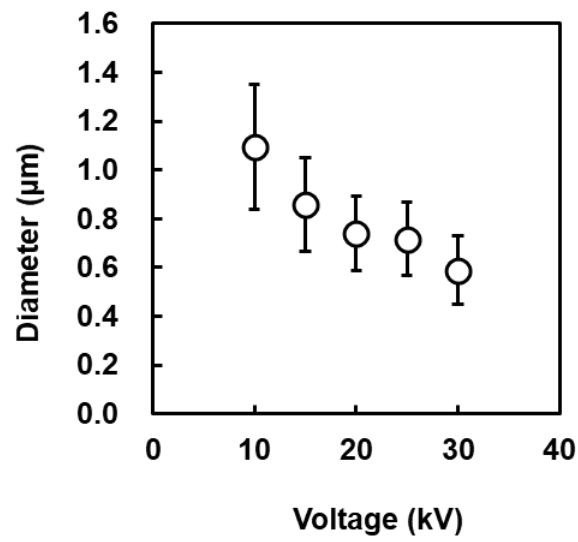
Figure 3. Effect of applied voltage on the PAA fiber diameter.